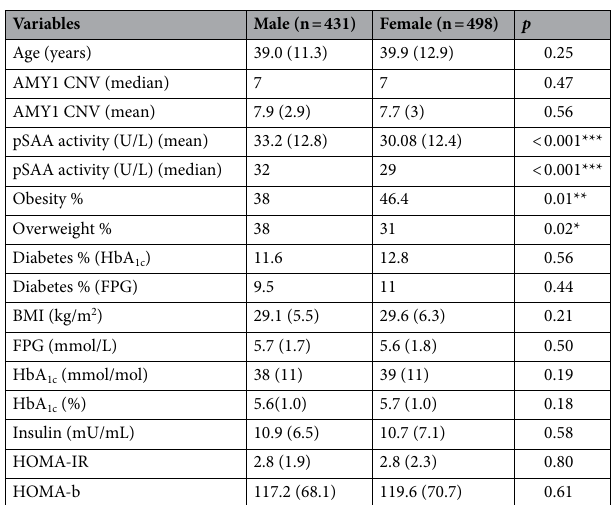
Table 1. General and clinical characteristics of the participants by gender. CNV copy number variations, pSAA activity plasma salivary alpha amylase activity, BMI body mass index, FPG fasting plasma glucose, HbA 1c glycated hemoglobin, HOMA-IR homeostatic model assessment of insulin resistance, HOMA-b homeostatic model assessment of beta cell